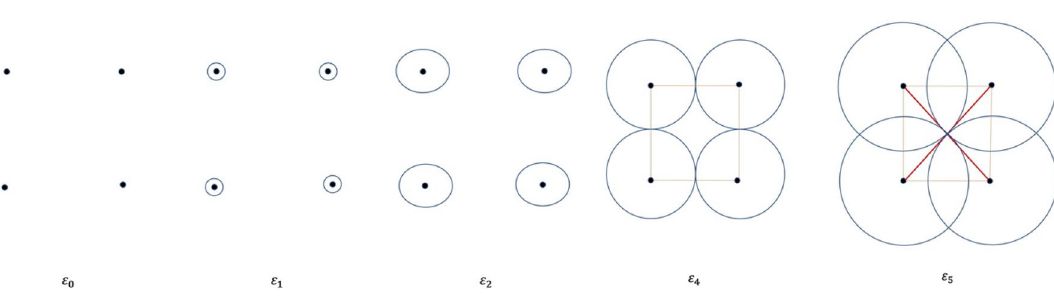
Figure 1. Construction of a simplicial complex using simplices.